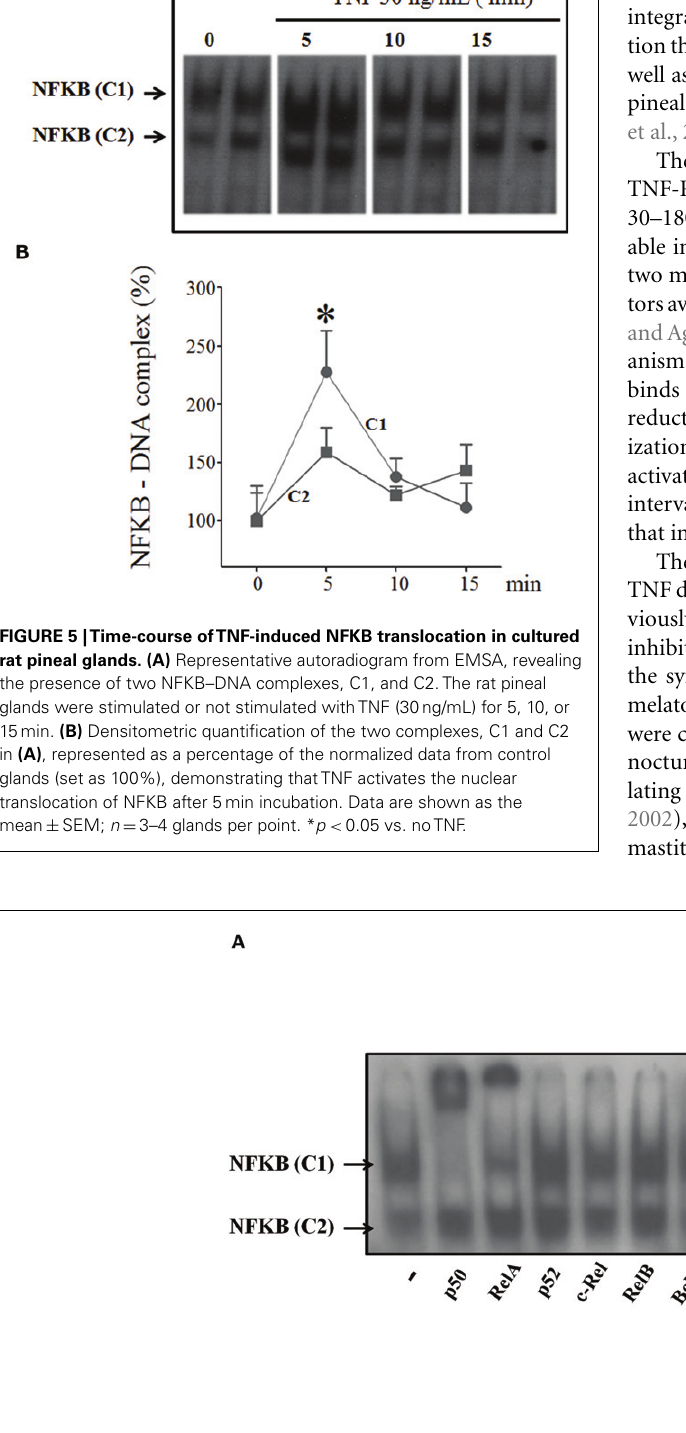
FIGURE 6 | Supershift NFKB assay of pineal nuclear extracts. (A) Representative autoradiogram showing nuclear NFKB supershifted by anti-p50 and anti-RelA.The antibodies for p52, c-Rel, RelB, and Bcl-3 did not supershift the NFKB dimers in nuclear pineal gland extract. (B) Plots obtained from the ImageJ gel analyzer.The plots show the